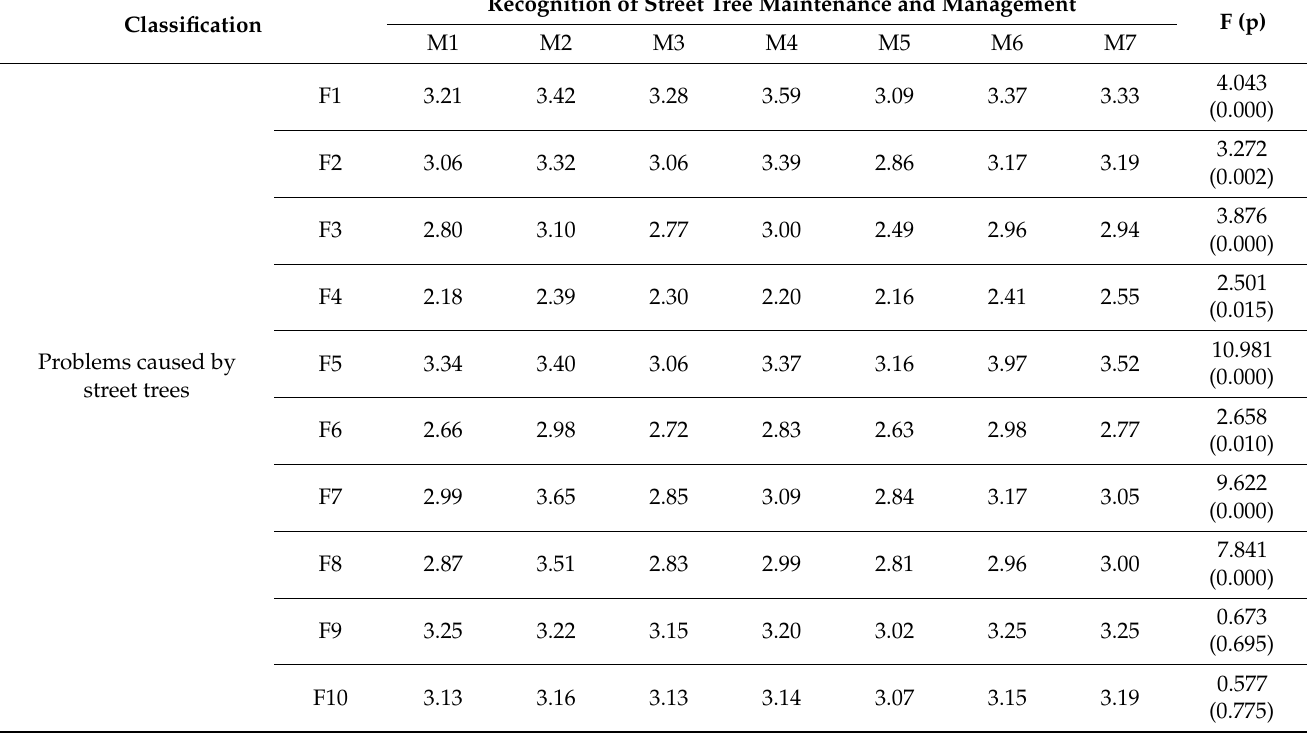
Table 11. Recognition of street tree maintenance and management factors and problems caused by street